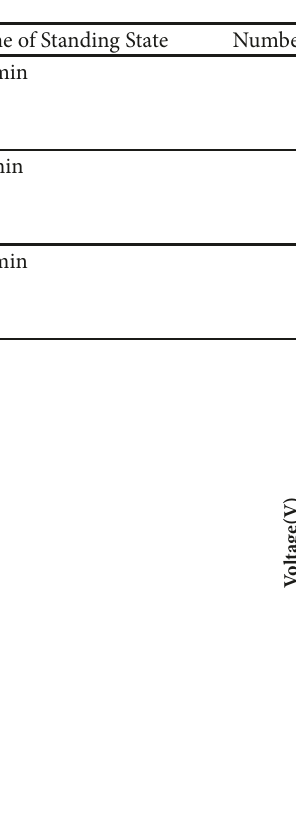
Table 2: Model error analysis.